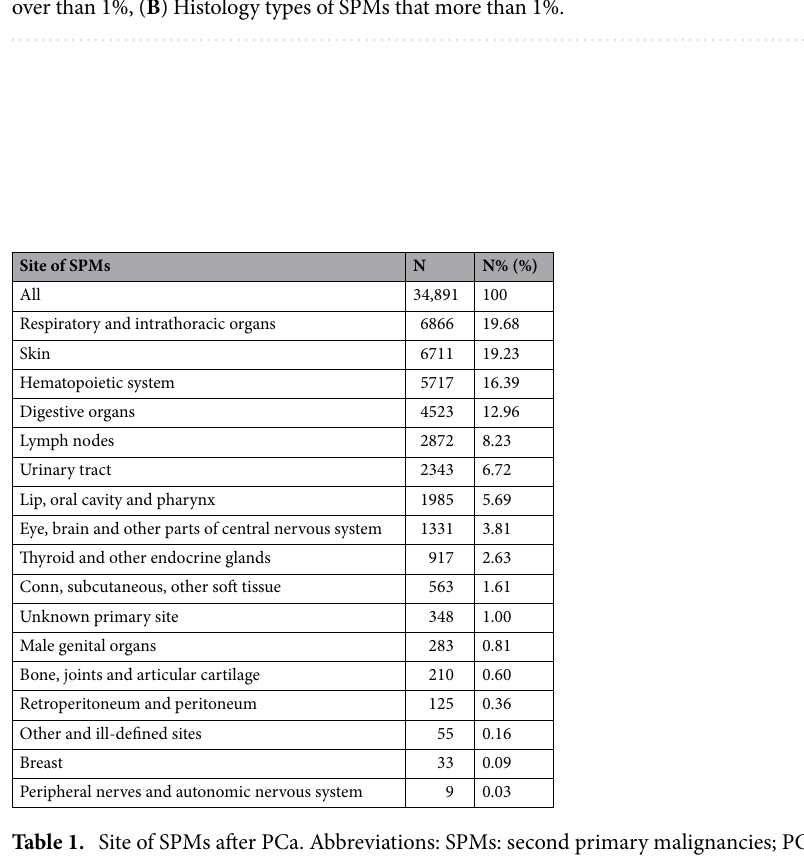
Figure 2. Features of second primary malignancies (SPMs) after prostate cancer (PCa). ( A ) Sites of SPMs that over than 1%, ( B ) Histology types of SPMs that more than 1%.